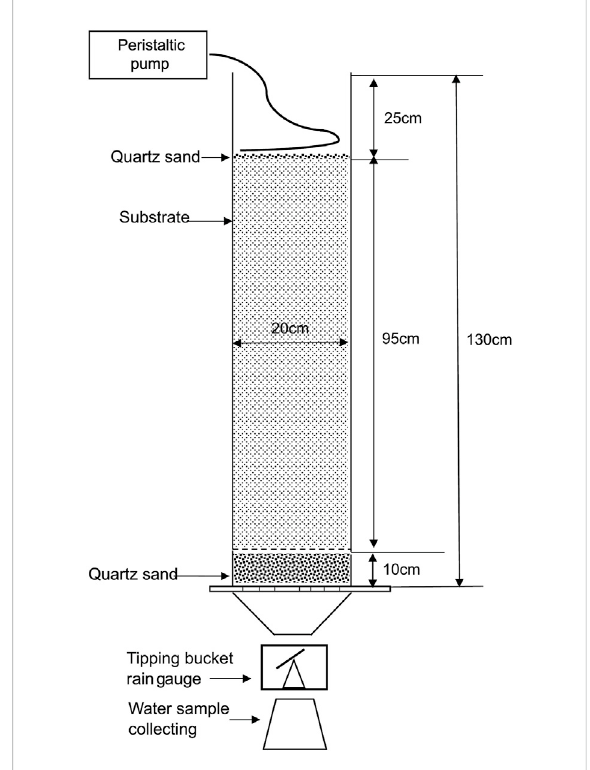
FIGURE 1 Experimental setup for media performance